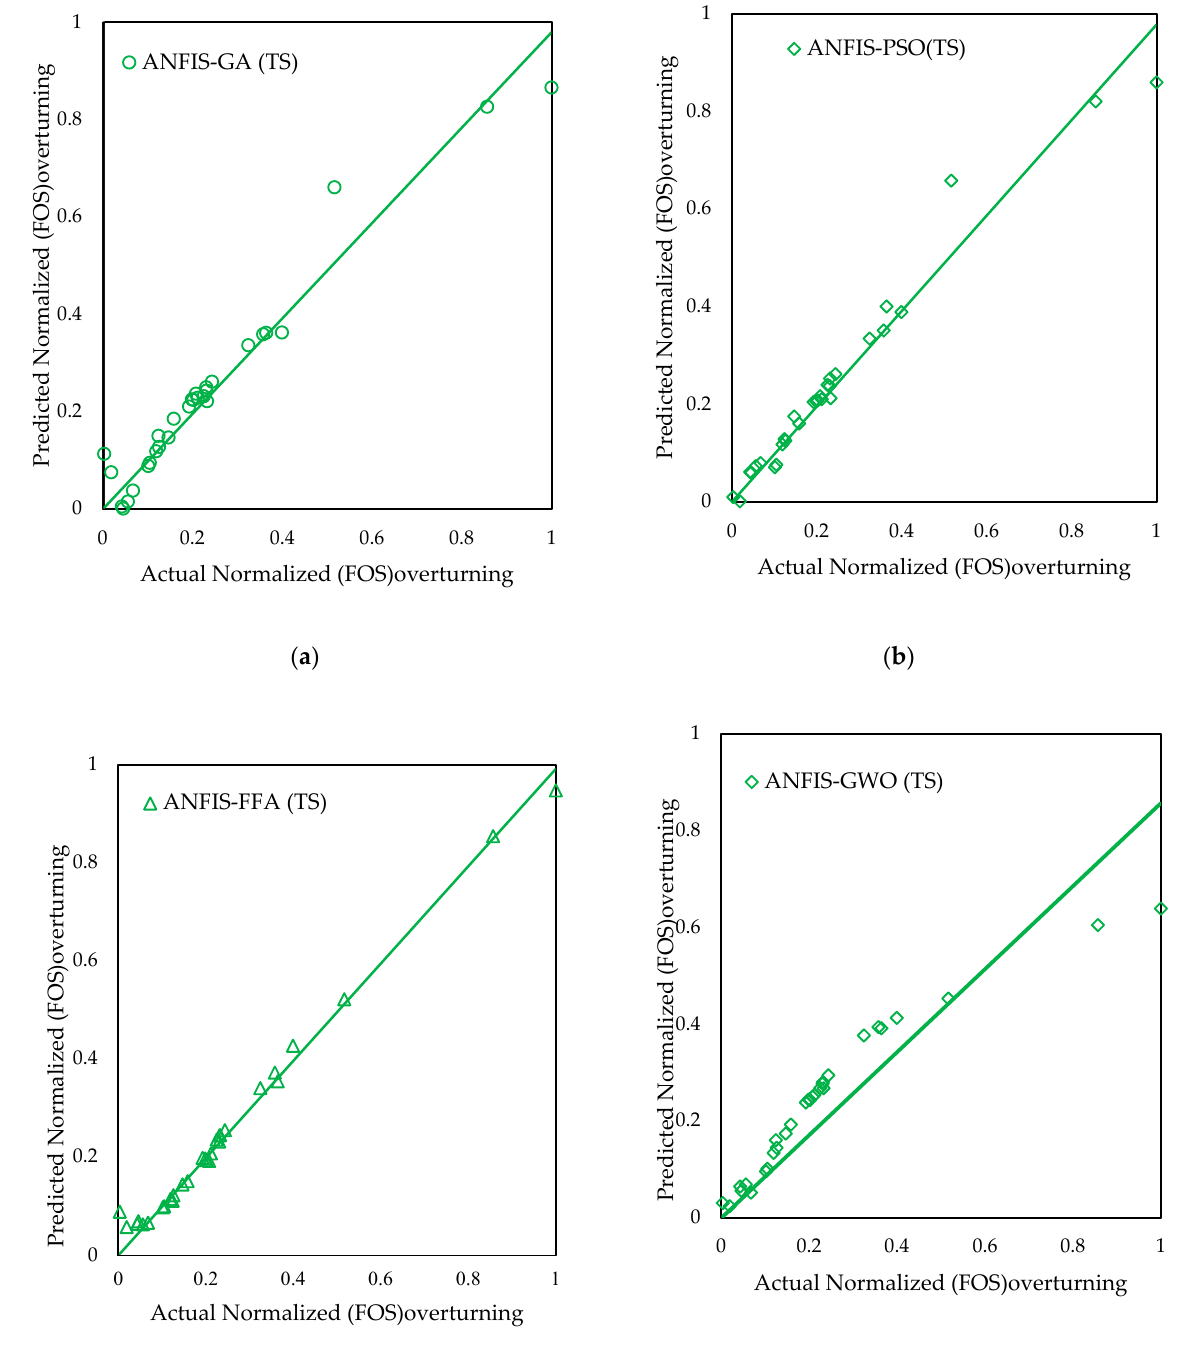
Figure 7. Plot of actual and predicted FOS of testing data (TS) for ( a ) ANFIS − GA; ( b ) ANFIS − PSO; ( c ) ANFIS − FFA; and ( d ) ANFIS − GWO models.